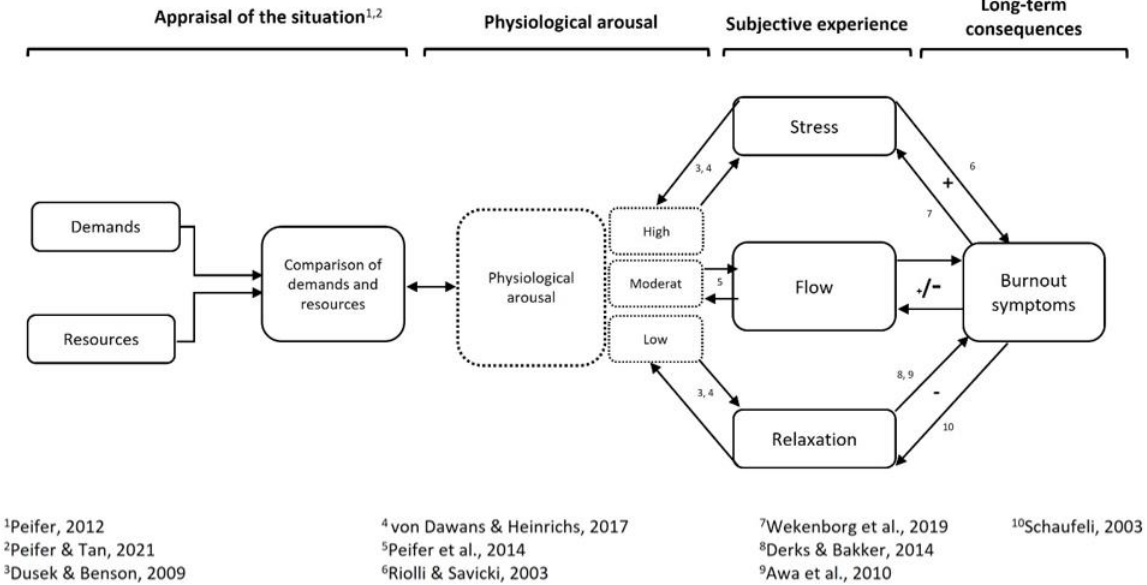
Figure 3. Adapted Flow-Burnout-Model (adapted from Peifer & Tan [39], Peifer [42]). + = positive association; - = negative association